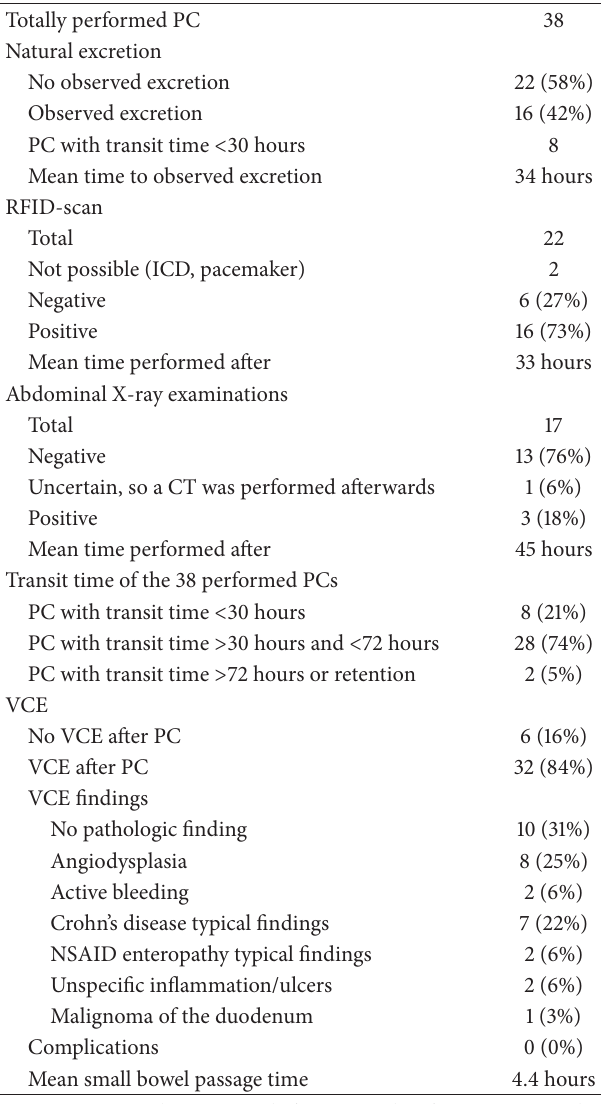
Table 2: PC and VCE findings: transit time of the PC shown by observed natural excretion, negative RFID-scan, or projection of the PC to the colon via radiological examination. Furthermore the findings of the VCE are shown. No complications appeared during the